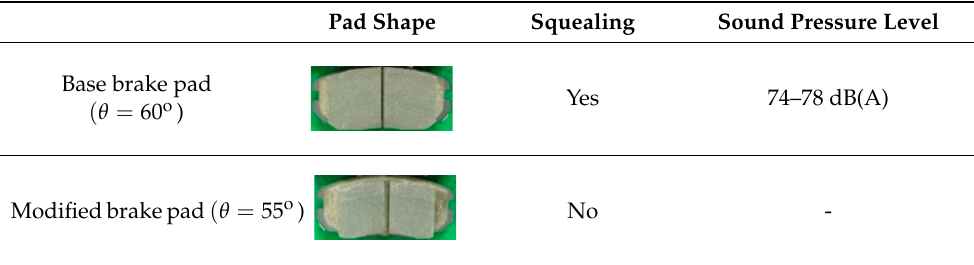
Figure 12. Measured spectral response of the microphone data: ( a ) base brake pad and ( b ) modified brake pad. Table 2. Chassis noise dynamometer test results.